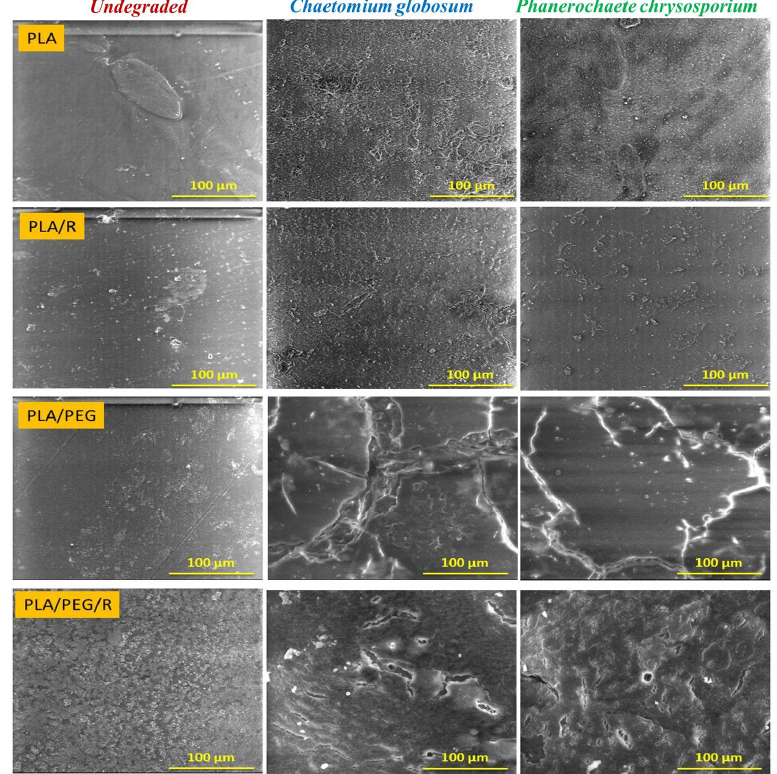
Figure 2. SEM micrographs (magnification of 1000×, scale bar—100 µm) of PLA-based samples after